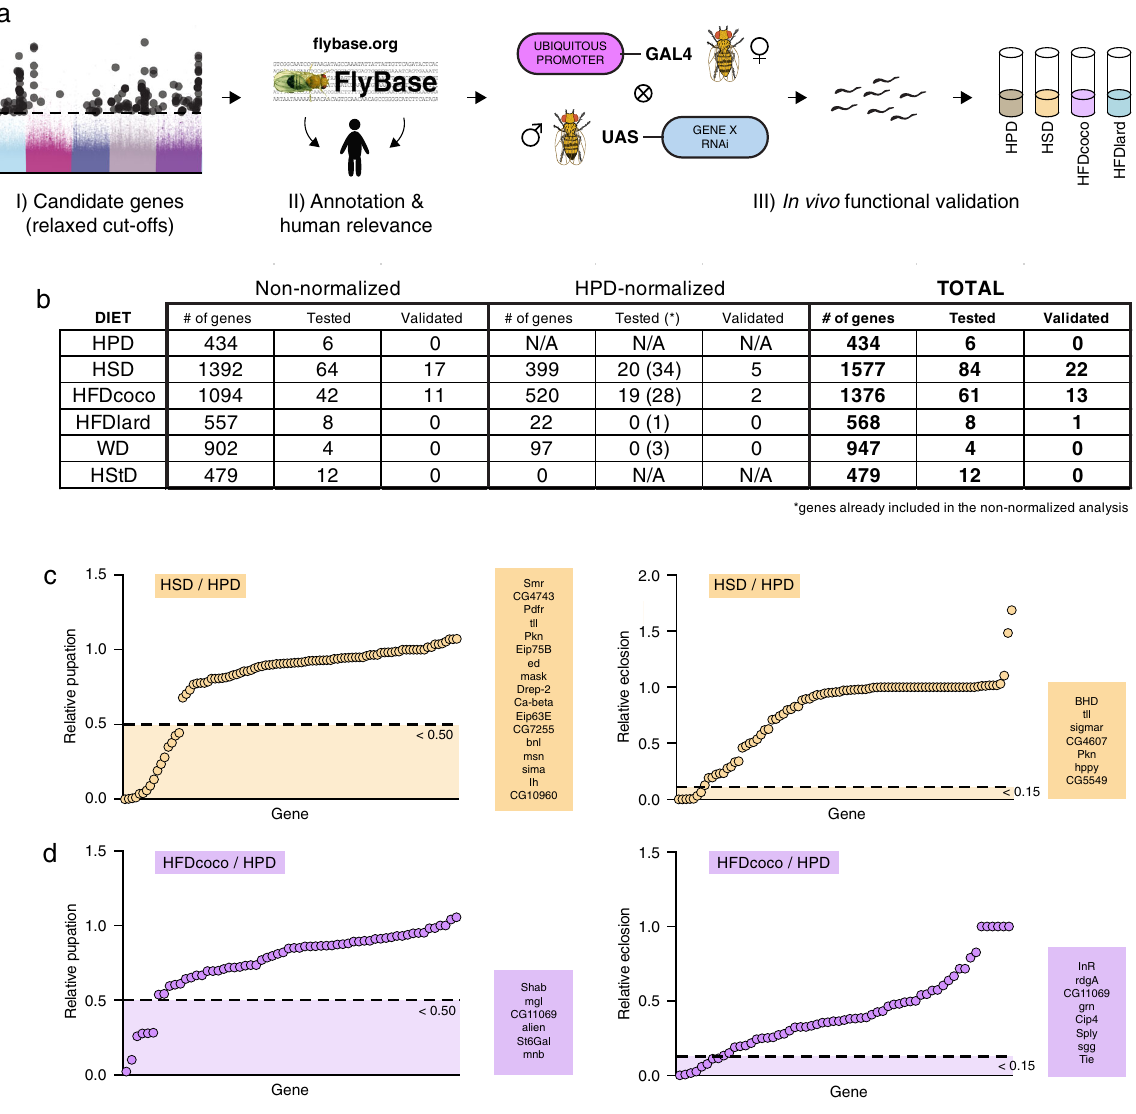
Fig. 3 In vivo functional validation screen. a A schematic outline of the functional validation screen. Please see FlyBase for further information: https:// fl ybase.org/ 86 . b A table presenting the number of genes identi fi ed with one or multiple SNPs associated with altered survival, the number of genes tested in functional validation screen, and the number of genes validated in the screen. c Plots for relative pupation and eclosion (HSD/HPD) of candidate genes. The dashed lines (0.5 for pupation and 0.15 for eclosion) present the chosen cut-off values. d Plots for relative pupation and eclosion (HFDcoco/HPD) of candidate genes. The dashed lines (0.5 for pupation and 0.15 for eclosion) present the chosen cut-off values. n = 2 – 3 vials (each with 30 larvae) per diet and (Fig. 3a, b and Supplementary Data File). For example, genes that were associated with poor survival on HSD were knocked down and the survival was assessed on HSD and compared to survival on HPD (the base diet). We used the Tub-GAL4 driver to obtain strong ubiquitous knockdown. In a case of early developmental lethality, a Ubi-GAL4 driver that is also ubiqui- tous but weaker in strength than Tub-GAL4 , was used as an alternative. Of the 165 genes tested (eight were candidates for more than one diet) 36 were validated. We used a cut-off of <0.5 for pupation phenotype hits (i.e., <50% of total pupation relative to pupation on HPD). Although candidate genes were selected based on pupation, some genes displayed an eclosion phenotype upon knockdown. To further interrogate potential genetic reg- ulators of macronutrient tolerance, we also focused on genes with a strong eclosion phenotype (cut-off of <0.15) (Fig. 3c, d and Supplementary Data 1).